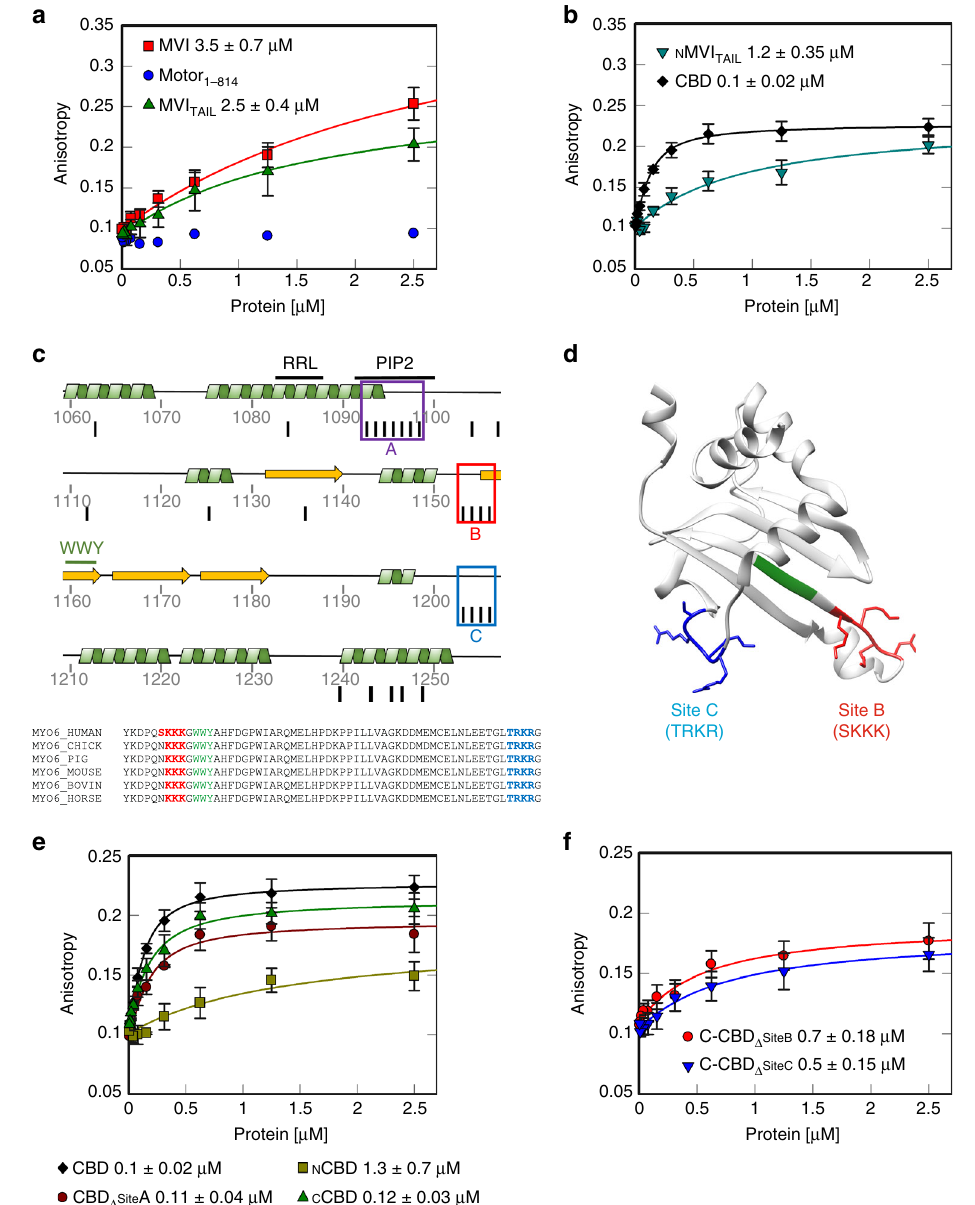
Fig. 2 DNA binding by myosin VI. a , b Fluorescence anisotropy titrations of MVI domains against a 40 bp fl uorescein amidite (FAM)-DNA (50 nM). Data fi tting was performed as described in Methods ( K ± SEM n = 3 independent experiments). Due to the low binding af fi nity, Motor fi tted d 1-814 could not be using the model. c Cartoon depicting the secondary structure within the CBD. Binding partner motifs and known lipid binding sites are highlighted along with three predicted clusters of DNA binding. Black lines represent residues predicted to be involved in DNA binding. Sequence alignment shows the conservation of sites B and C. d Structure of C CBD with site B (red), C (blue) and WWY motif (green) (PDB:2KIA 54 ). e , f Fluorescence anisotropy titrations of CBD constructs, as performed in